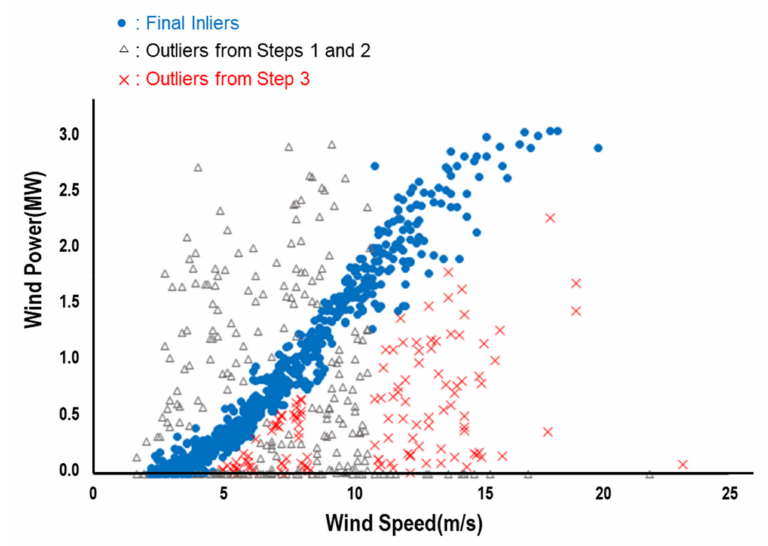
Figure 7. Refined Data for Power Curve Modeling of 3.0 MW Turbine.